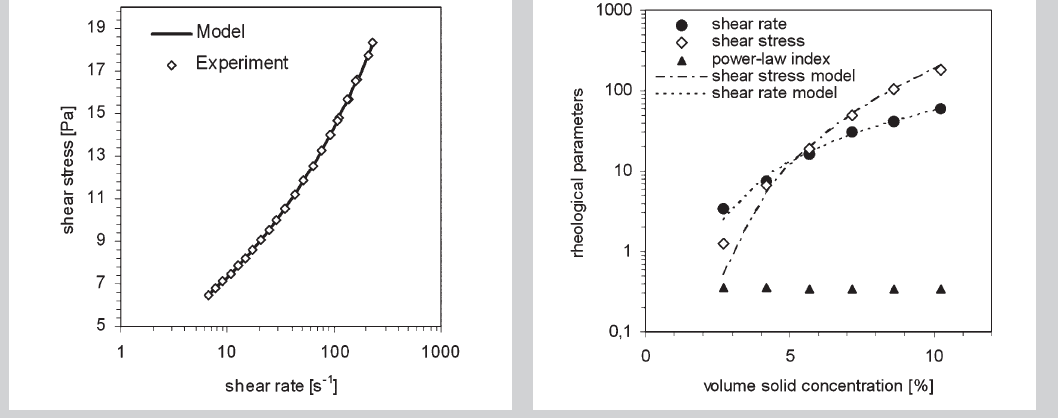
Figure 7 (left): Flow curve of a pasty sludge at 5.8% DM ( g · =6.65 s -1 , c g · = 6.5 Pa, n = 0.3). c Figure 8: Critical shear rate and shear stress in relationship with the solid content for a single sludge which was diluted. Continuous lines indicate the model with the follow- ing values: k = 0.14, m = 1.20, q = 3.30, p = 1.77, F = 0